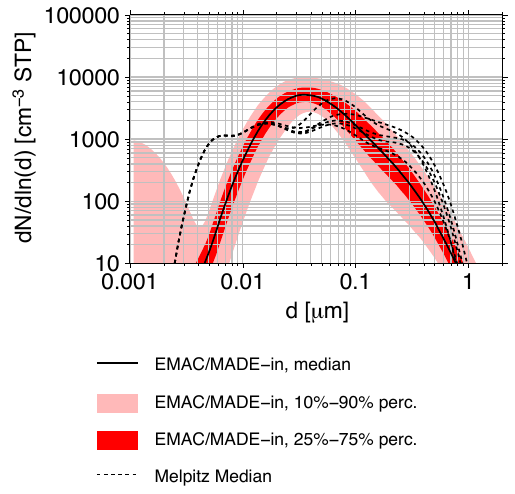
Fig. 11. Aerosol number size distributions at surface level as ob- served by Birmili et al. (2001) in the region of Melpitz, Germany, and corresponding model values. The dashed lines show the size distributions for different air masses and weather conditions. The simulated number size distribution is a climatological median of 10yr and refers to the dry